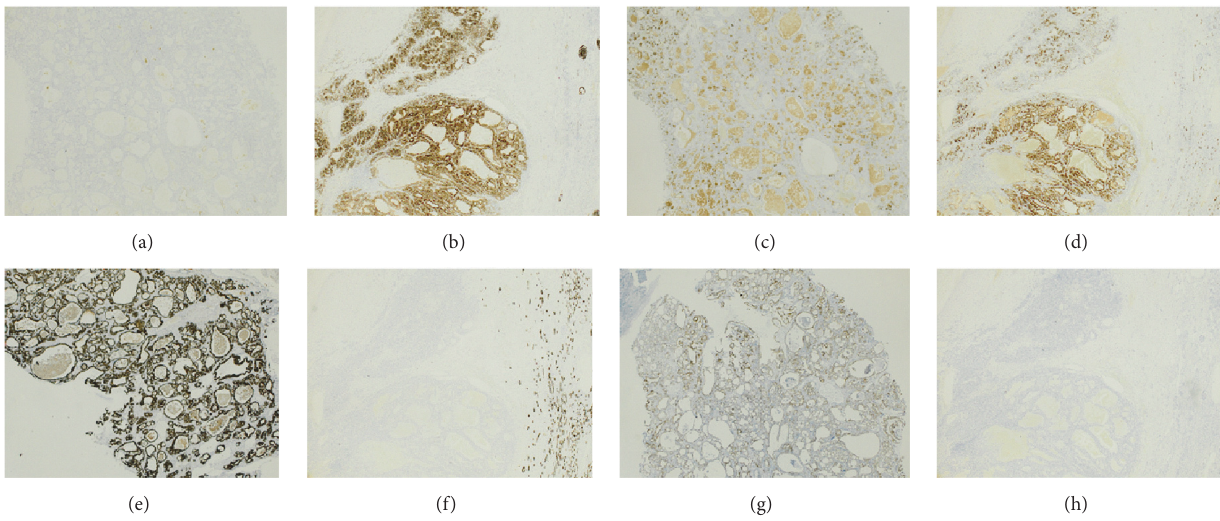
Figure 2: Immunohistochemistry (IHC) of renal and sinonasal tumours, × 2. (a) Sinonasal tumour cells were negative for CD10. (b) Renal tumour cells were strongly positive for CD10. (c) Sinonasal tumour cells were negative for RCC; however, weak staining of luminal secretions was seen. (d) Renal tumour cells demonstrated strong positivity for RCC marker. (e) Sinonasal tumour cells demonstrated positivity for CK7. (f) The renal tumour was negative for CK7; however, in this image a proximal renal tubule was seen to exhibit CK7 positivity. (g) The sinonasal tumour exhibited patchy CK20 positivity. (h) The renal tumour was negative for CK20.